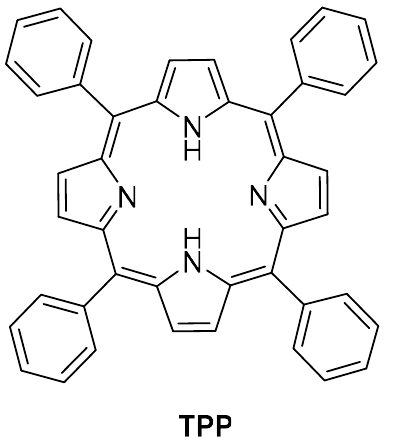
Figure 13. Structure of 5,10,15,20-tetraphenylporphyrin ( TPP ), the first meso -tetraarylporphyrin (tArPs) synthesized in laboratory.